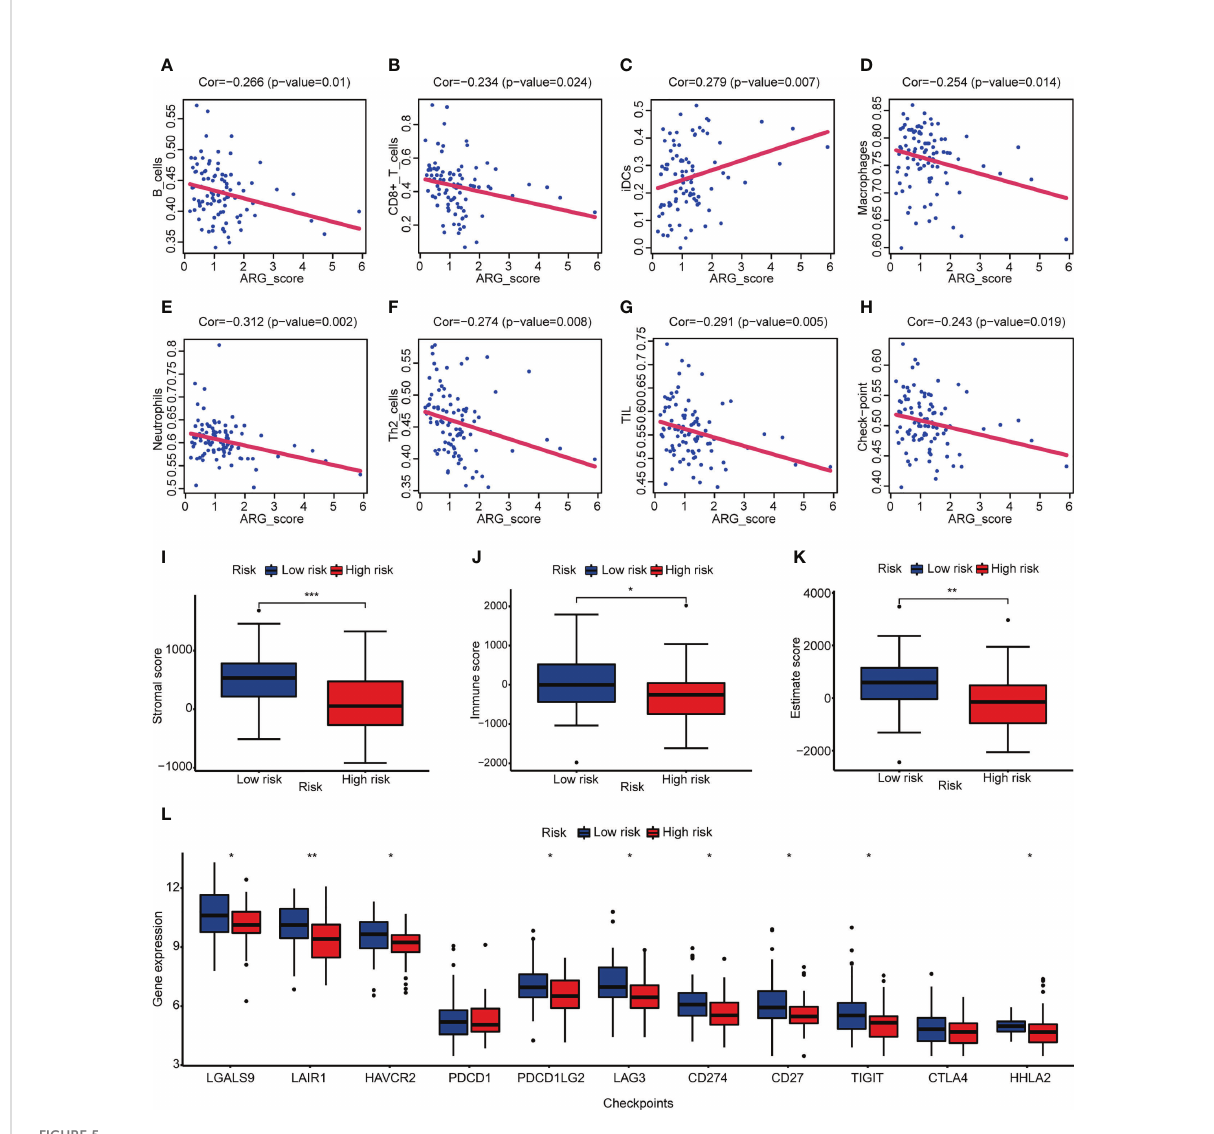
FIGURE 5 Correlation between ARG_score and immune in fi ltration. (A – H) Correlation analysis between ARG_score and immune cell/checkpoint. (I – K) Stromal score, immune score, and estimate score of the low- and high-risk groups. (L) Expression levels of checkpoint molecules in the low- and high-risk groups. (* p < 0.05, ** p < 0.01, *** p <